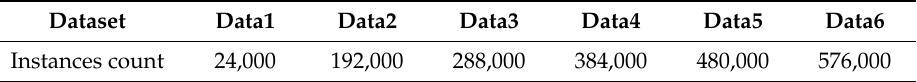
Table 2. The data set scales used in the